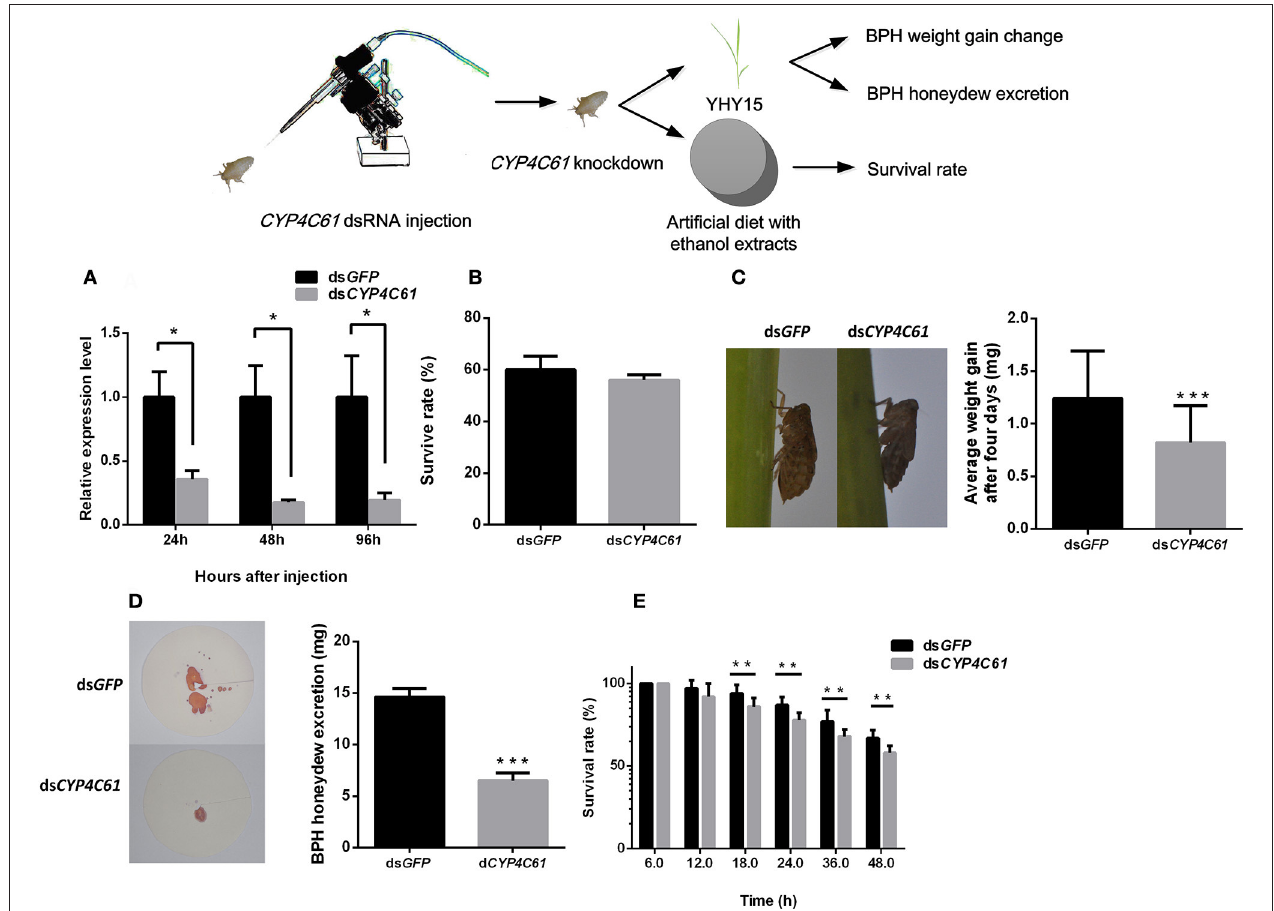
FIGURE 4 | Phenotype resulting from biotype Y BPH CYP4C61 knockdown. (A) qRT-PCR analysis of the effects of CYP4C61 knockdown at different time points. (B) Survival rates of biotype Y BPHs treated with CYP4C61 and GFP dsRNA. GFP dsRNA-treated BPH served as the control. (C) Weight gain of dsRNA-treated BPH. (D)